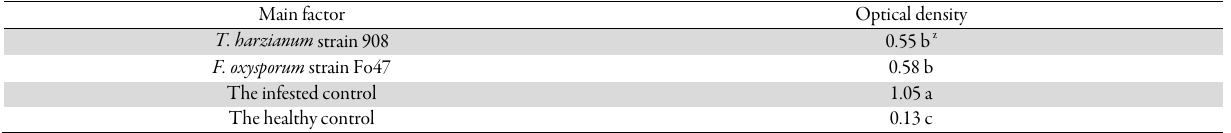
Table 1. Efficacy of the main factor (two antagonists: F. oxysporum and T. harzianum ) in the suppression of BNYVV multiplication in greenhouse conditions